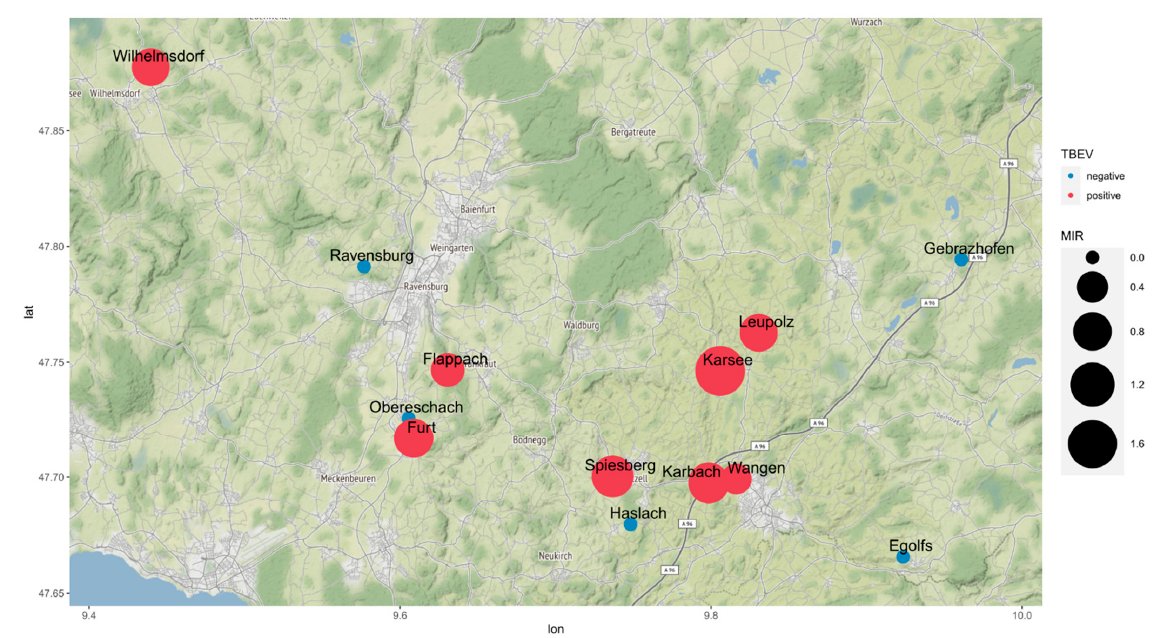
Figure 3. Geographical distribution of TBEV-positive Ixodes ricinus ticks in the Ravensburg district. Topological map of the Ravensburg area displaying a detailed localization of sampled sites. Point sizes scaled by the minimal infection rates of individual sites. The point color indicates results of the TBEV-RT-qPCR. Table 2. Number of sampled ticks, tabulated by developmental stage and location. Positive loca- tions are in bold font. Numbers in brackets indicate the number of TBEV-positive tick pools. Altitude (m Location above s.l.)